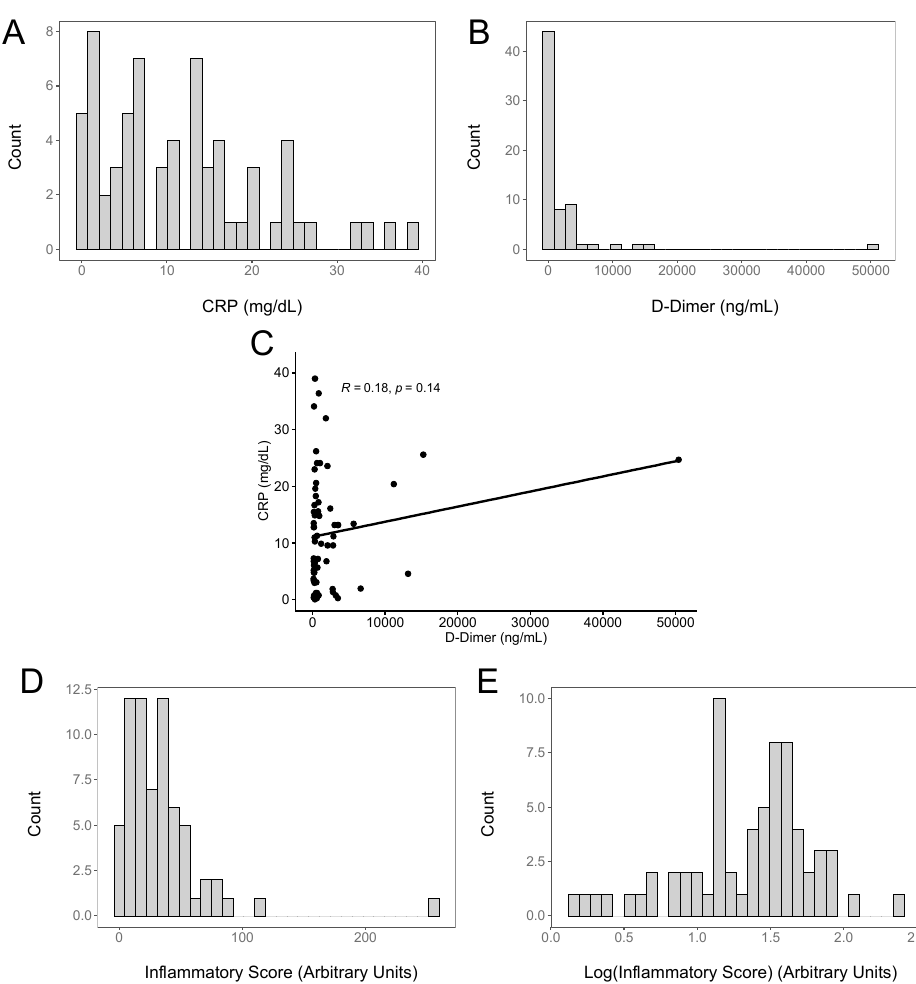
Figure 2. Inflammatory markers in acute COVID-19 patients. ( A ) Binned histogram of CRP values for the study population. ( B ) Binned histogram of D-Dimer values for the study population. ( C ) Correlation of CRP and D-Dimer values for each patient. ( D ) Binned histogram for the composite inflammatory score (CIS) for the study population. ( E ) Binned histogram of Log 10 -transformed CIS for the study population.